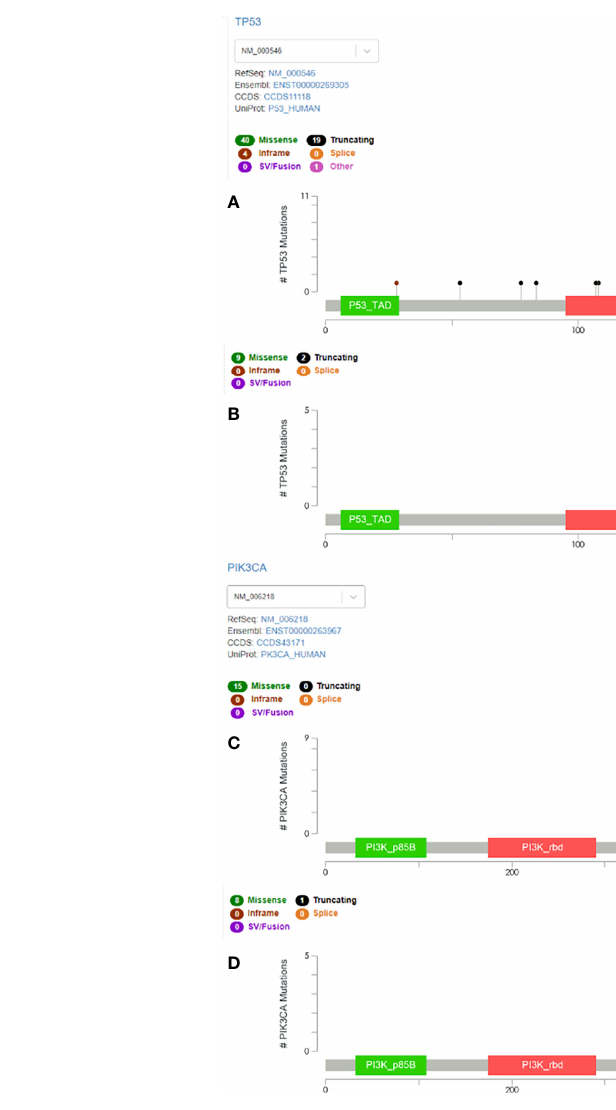
FIGURE 4 | Lollipop diagram of the TP53 and PIK3CA domains with the mutation location identi fi ed in TNBC patients. Different types of mutations were colored by different colored dots, and each colored dot represents one mutation. The length of the lollipop represents the number of patients harboring a speci fi c variant. (A) The type and location of TP53 mutation in NST patients. (B) The type and location of TP53 mutation in ST patients. (C) The type and location of PIK3CA mutation in NST patients. (D) The type and location of PIK3CA mutation in ST patients. TNBC, triple-negative breast cancer; NST, no-special type; ST, special